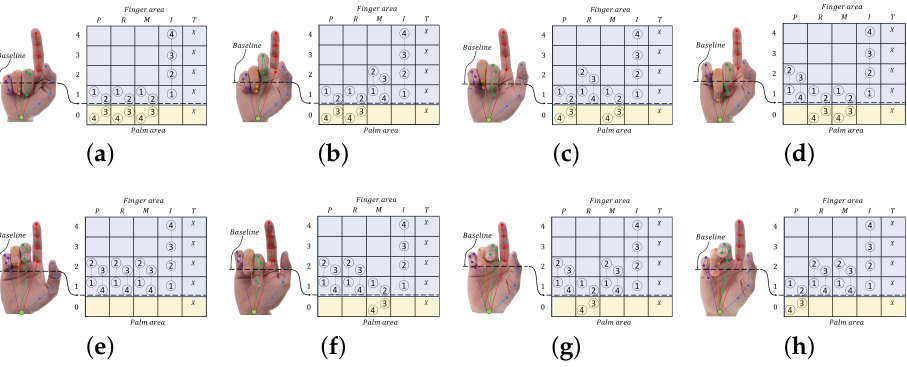
Figure 7. Hand pointing patterns: ( a ) Pattern PT 1 , ( b ) Pattern PT 2 , ( c ) Pattern PT 3 , ( d ) Pattern PT 4 , ( e ) Pattern PT 5 , ( f ) Pattern PT 6 , ( g ) Pattern PT 7 , and ( h ) Pattern PT 8